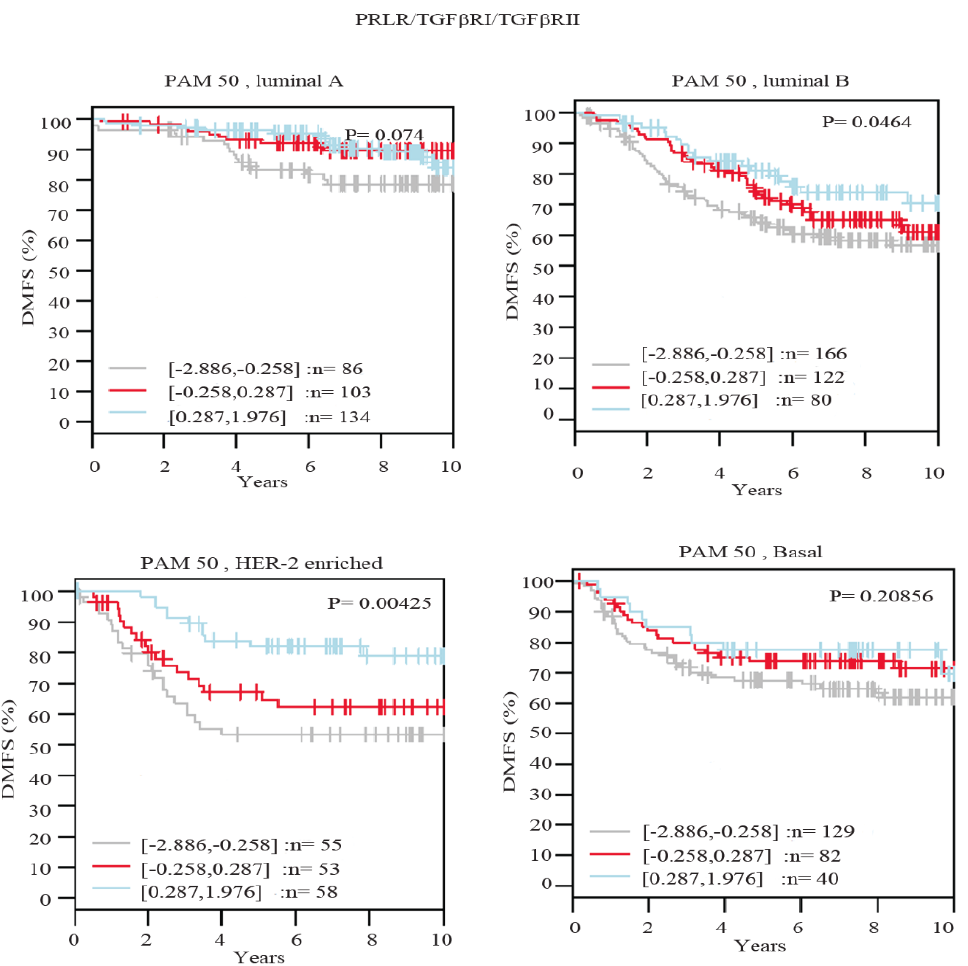
Figure 5. The association between PRLR/TGF β RI/TGF β RII gene signature and patient outcome in different breast cancer subtypes.